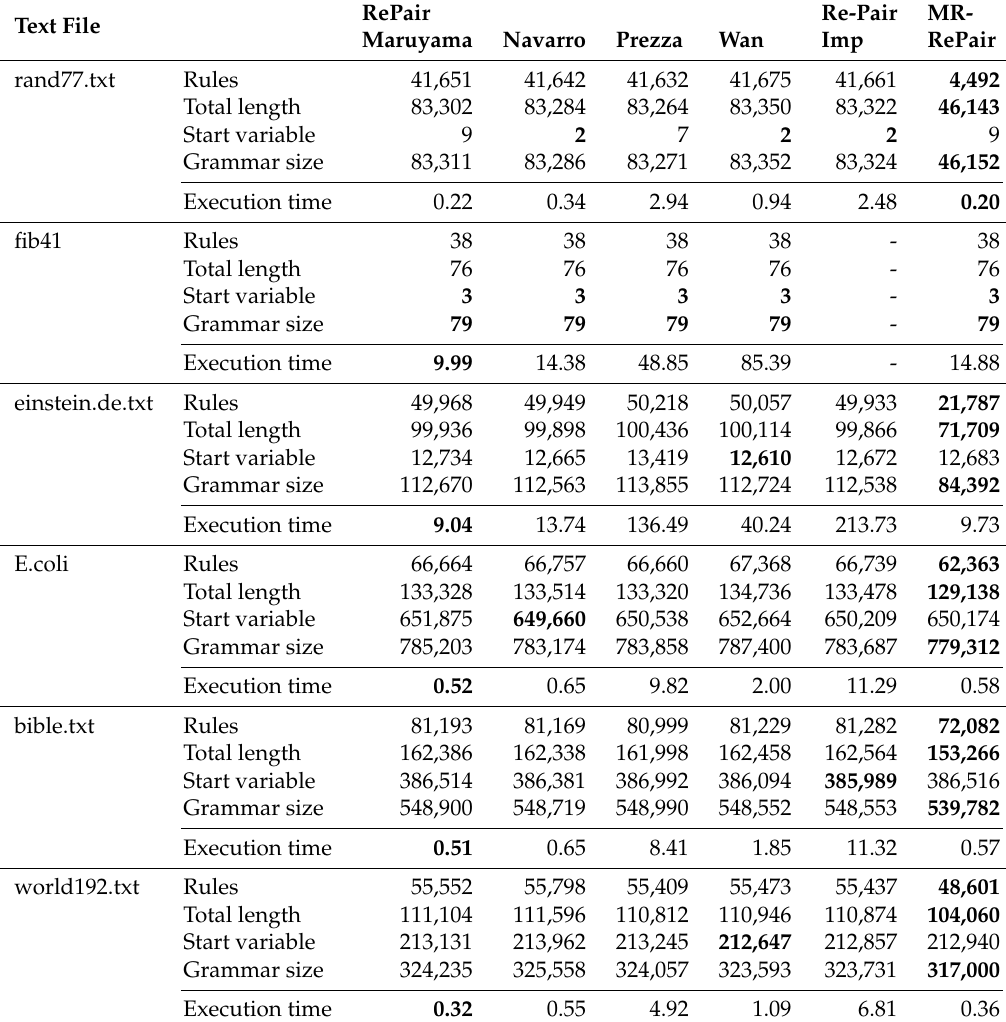
Table 2. Sizes of generated grammars and execution times of the considered algorithms. Each cell in the table represents the number of generated rules, total lengths of the right side of all of the rules except for the start variable, length of the right side of the start variable, and the total grammar size in the order from the top row. The total grammar size presented in the fourth row is the total of the values presented in the second row and the third row. The fifth row separated by a line represents the execution time for compression in seconds. The best results are highlighted in